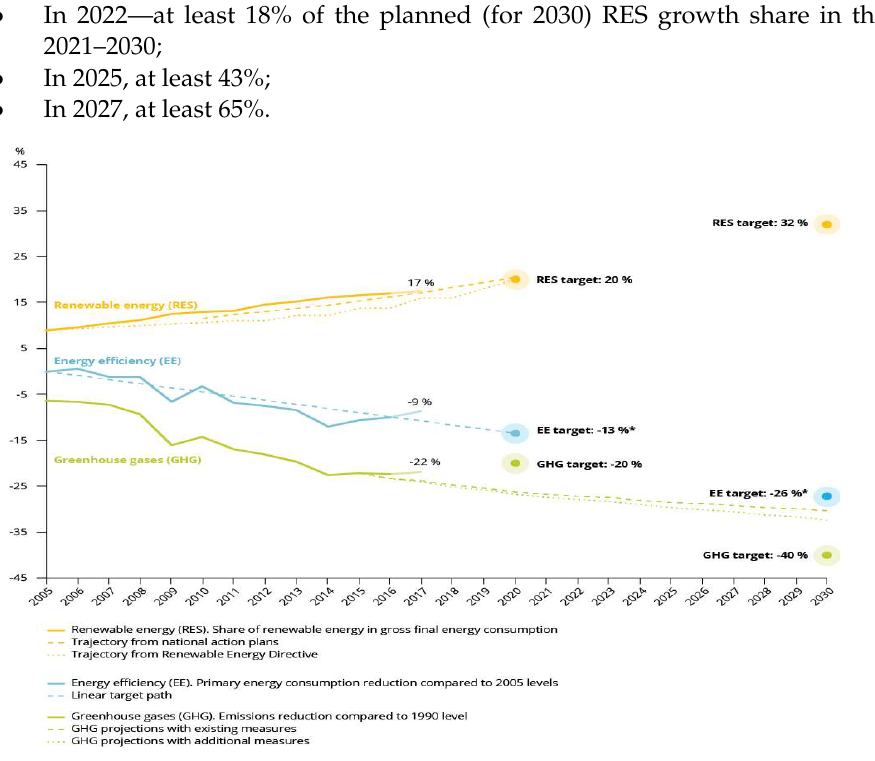
Figure 4. The European Green Deal. Source: [26]. Such a goal is a very ambitious developmental challenge both economically and socially. However, it is advisable to undertake such challenges considering potential benefits resulting from the reduction or possibly even halting of the progressive increase